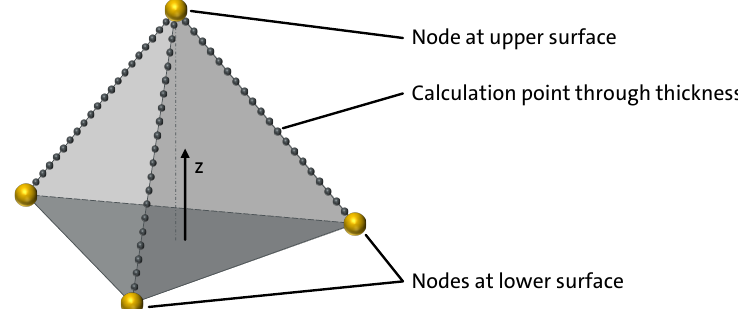
Figure 2. Schematic illustration of a tetra element in the morphing method with one node at the top, 3 nodes at the bottom, and 20 calculation points through the thickness for Light 3D analyses in 3D TIMON CompositePRESS.